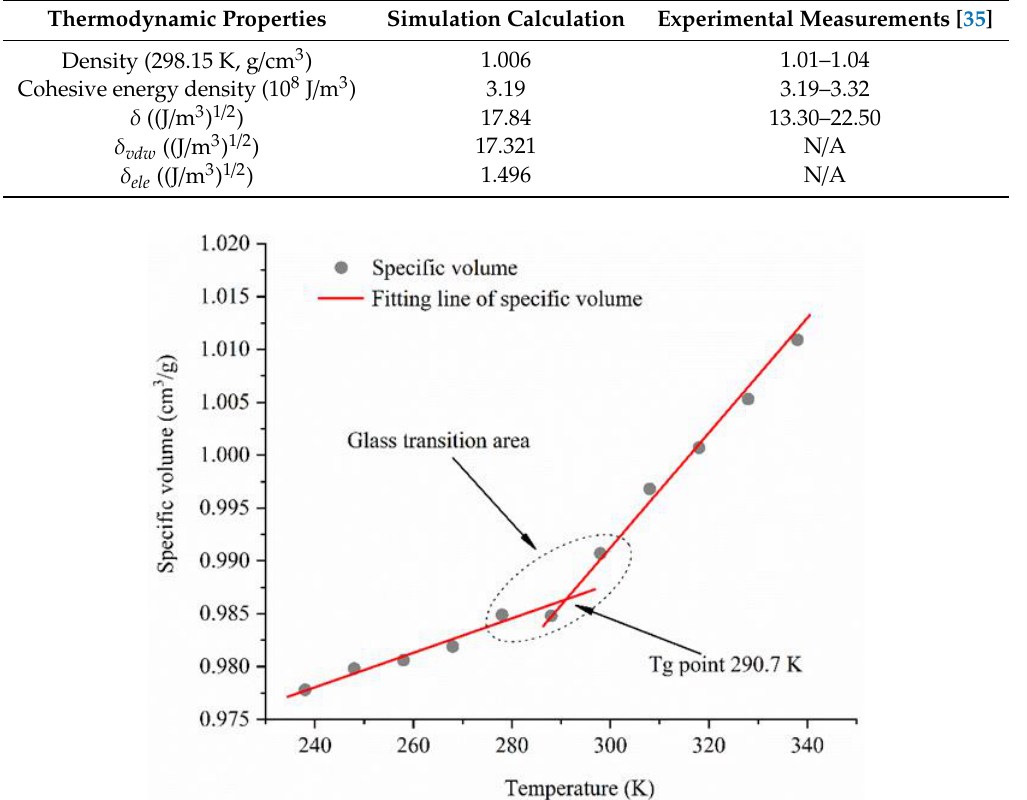
Figure 3. Relationship between specific volumes and temperatures.